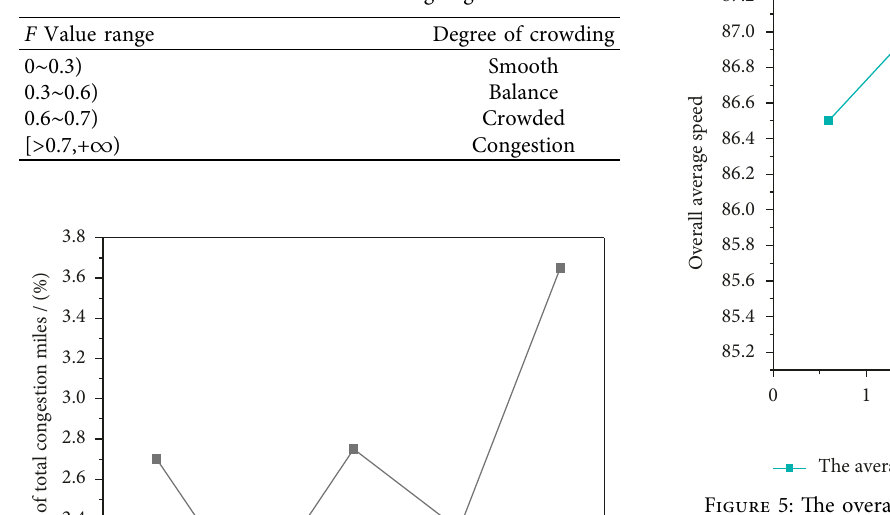
Table 1: Evaluation of crowding degree.